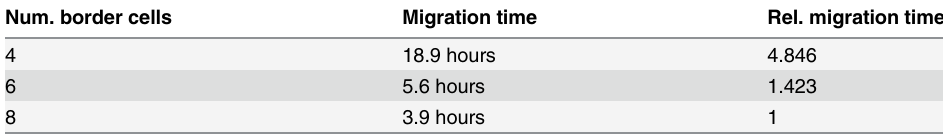
Table 2. The total time and relative time taken for computational clusters of 4, 6 and 8 border cells to complete migration. Num. border